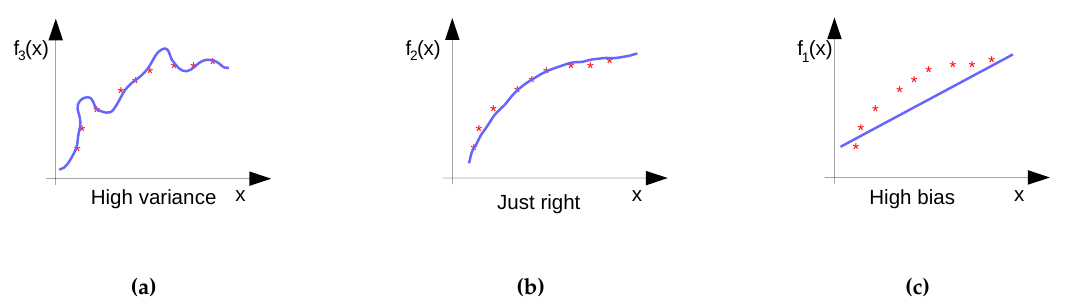
Figure 11. Explanation of bias-variance problem ( a ) High variance; ( b ) Optimally trained model; ( c ) High